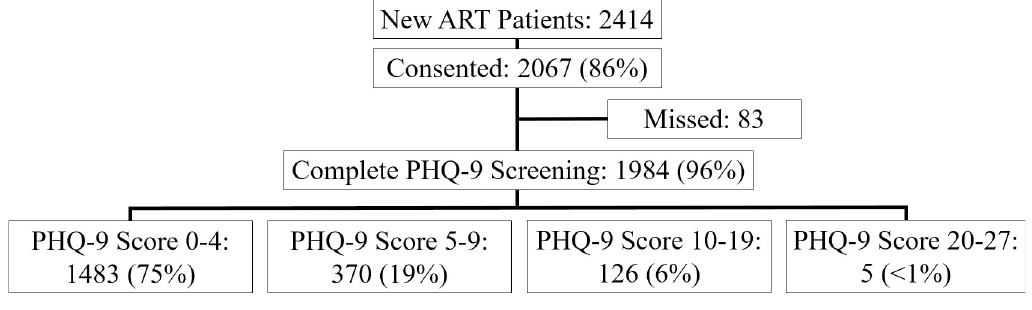
Fig 2. Evaluation enrollment.